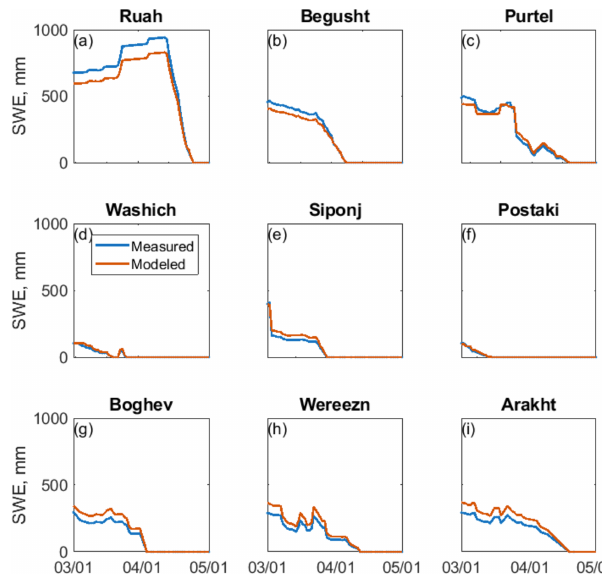
Figure 6. Model vs. measured SWE at selected AKAH stations for 2017 March to